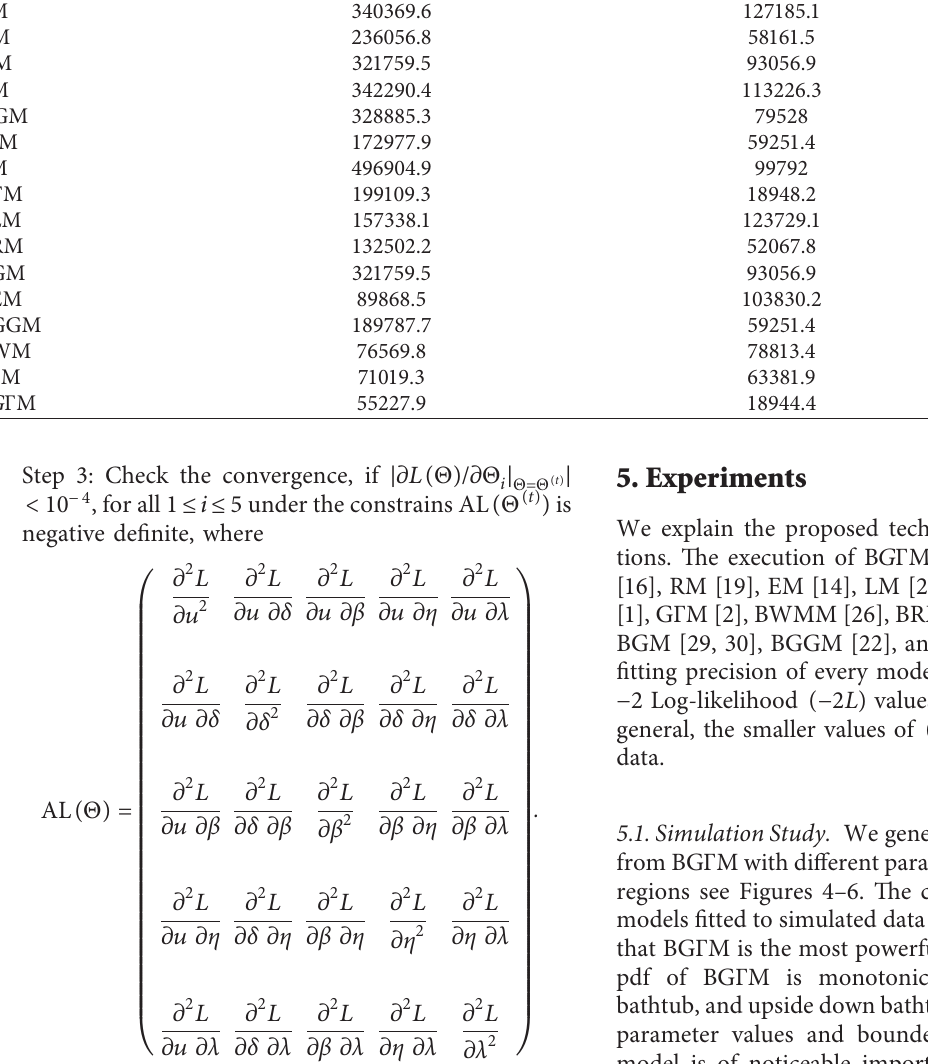
Table 4: The corresponding − 2 L values of models fitted to simulated data in Figures 4–6.